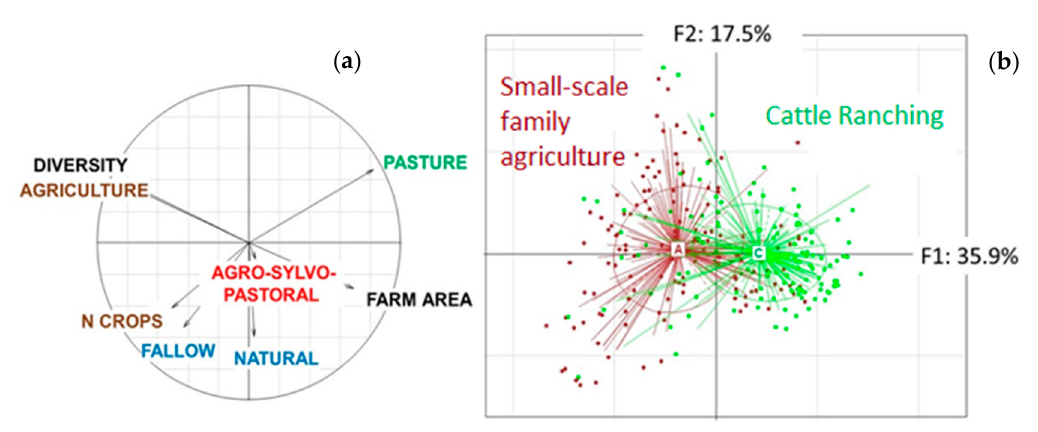
Figure 8. ( a ) Projection of farms from the two different areas on factorial plane F1F2 of a principal component analysis. ( b ) Projection of the cluster analysis: The separation between farms from the small-scale family agriculture (A) and cattle ranching (C) system was significant ( p < 0.01, with 12% of variance explained).